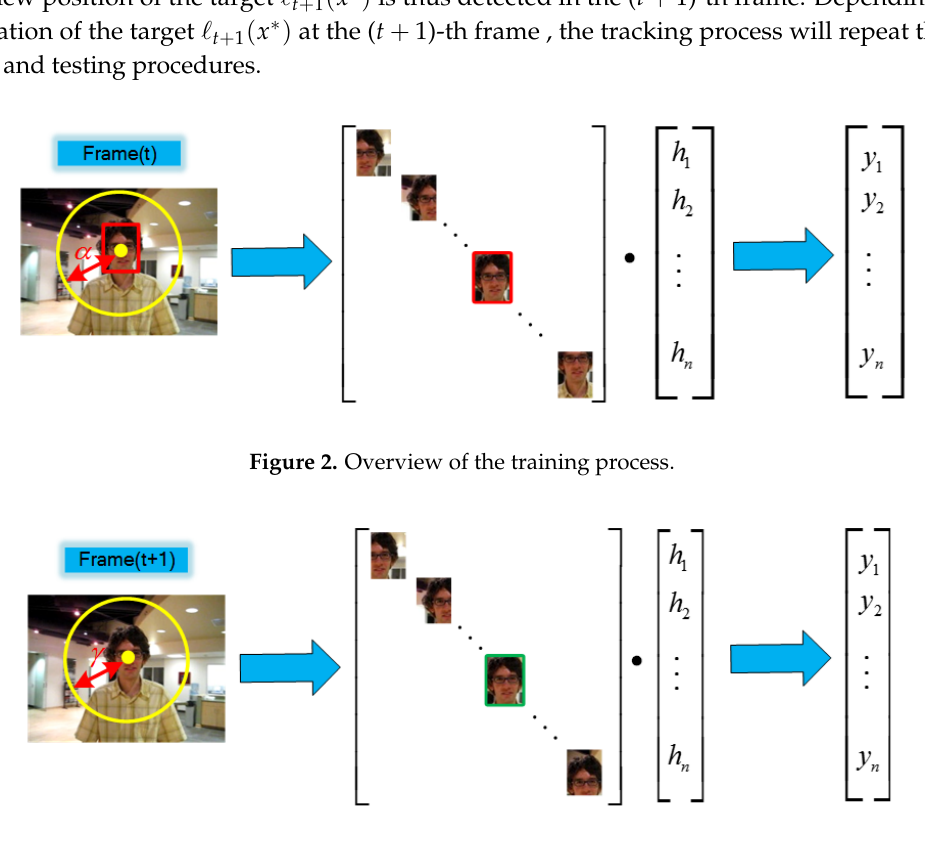
Figure 3. Overview of the testing